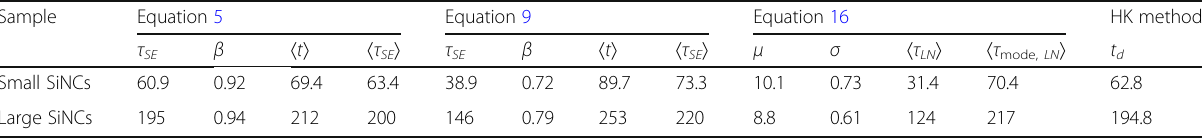
Table 2 Fitting parameters, mean lifetimes, and mean decay times obtained for Eqs. 5, 9, and 16 for the small and large SiNC samples. For the lognormal function (Eq. 16), the last column shows the mode (i.e., the most common lifetime). All lifetimes are